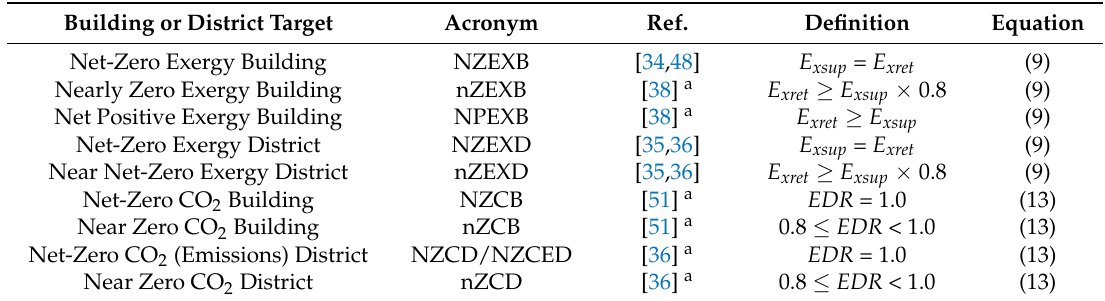
Table 1. Building and District Level Net and Near Zero Definitions Based on Exergy.